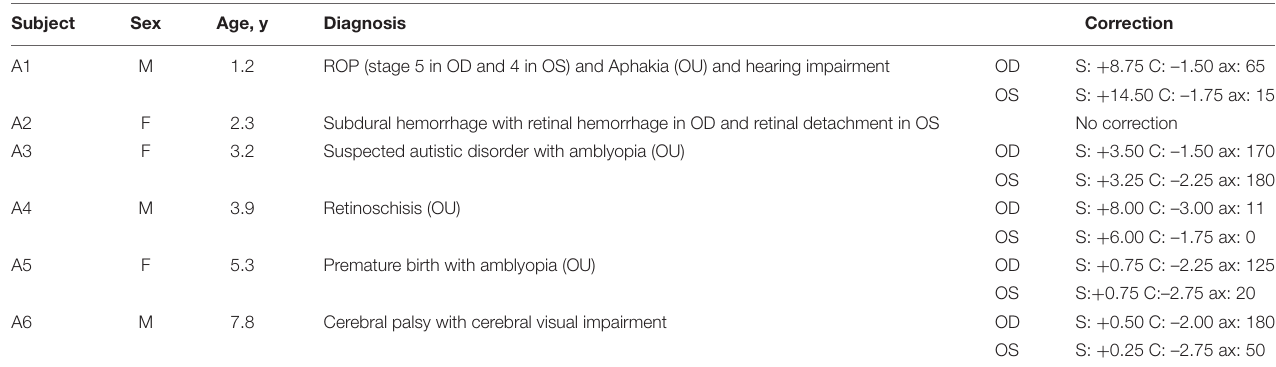
TABLE 1 | Participants’ demographic information ( n =